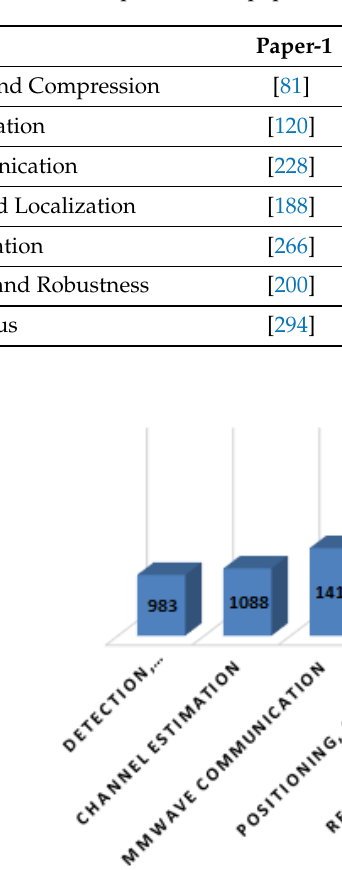
Table 3. Top most cited papers from each category (left to right in descending order).